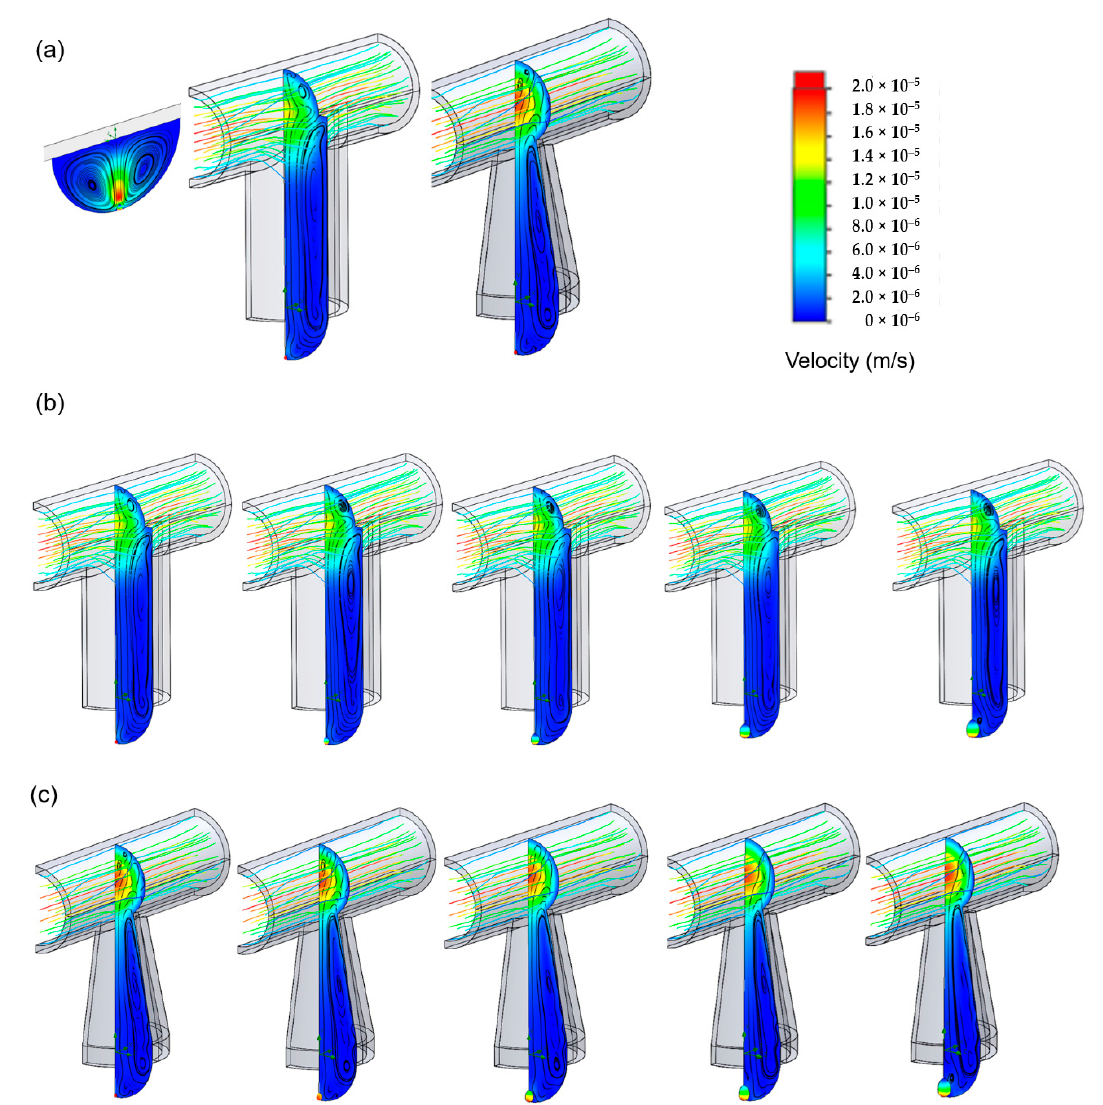
Figure 5. Simulation for spheroid formation. ( a ) Original setting for three culture methods: traditional hanging-drop, cylindrical tube microfluid chip, and taper-shaped microfluid chip; the pressure field exchange on the cell surface during the spheroid formation: ( b ) in the cylindrical tube microfluid chip, ( c ) in the tapered tube microfluid chip.